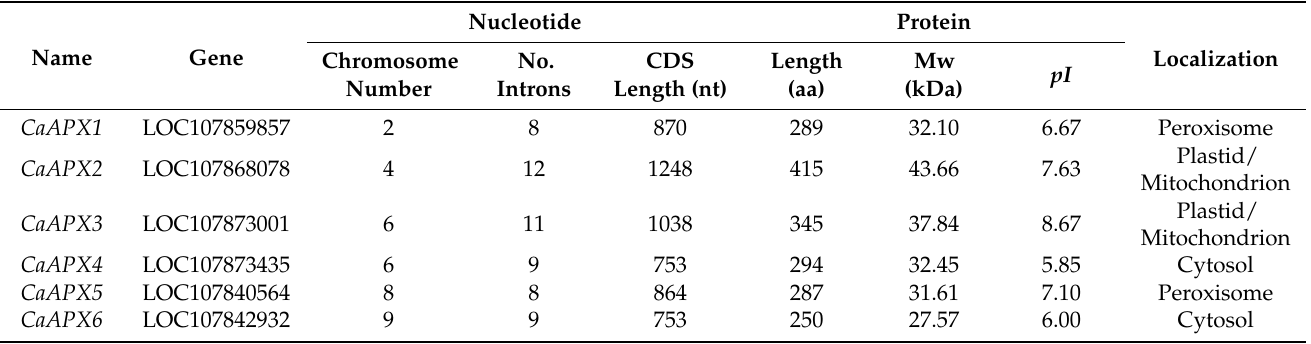
Figure 2. Phylogenetic analysis of CaAPX proteins from diverse plant species. The evolutionary history was inferred by using the Maximum Likelihood method and JTT matrix-based model. The tree with the highest log-likelihood is shown. This analysis involves 42 amino acid sequences. Evolutionary analyses were conducted in MEGA X. The scale bar represents the phylogenetic branch length. Clade I, II, and III include the chloroplastic/mitochondrial, cytosolic, and peroxisomal APX proteins, depicted in green, red, and yellow, respectively. Species abbreviations: At ( Arabidopsis thaliana ); Ca ( Capsicum annuum ); Os ( Oryza sativa ); Ptr ( Populus trichocarpa ); Sl ( Solanum lycopersicum ); and St ( Solanum tuberosum ). Table 1. Sweet pepper genes encoding APX isozymes. Protein length as the number of amino acids (aa) corresponds to the pre-processed polypeptides. Theoretical pI and molecular weight (Mw) of each mature protein were predicted in silico using the Compute pI/Mw tool on the ExPASy server. Subcellular localization was predicted using WoLF